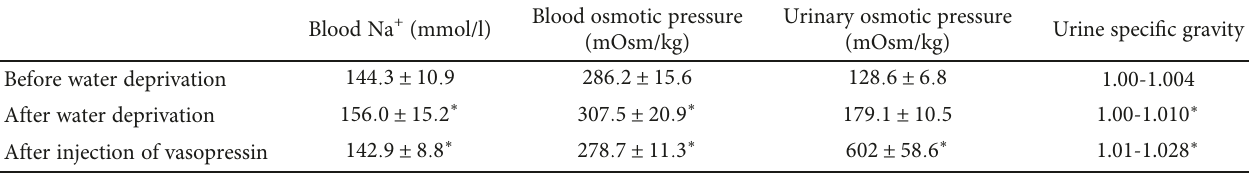
Table 2: Results of water deprivation and vasopressin test in patients with CID.